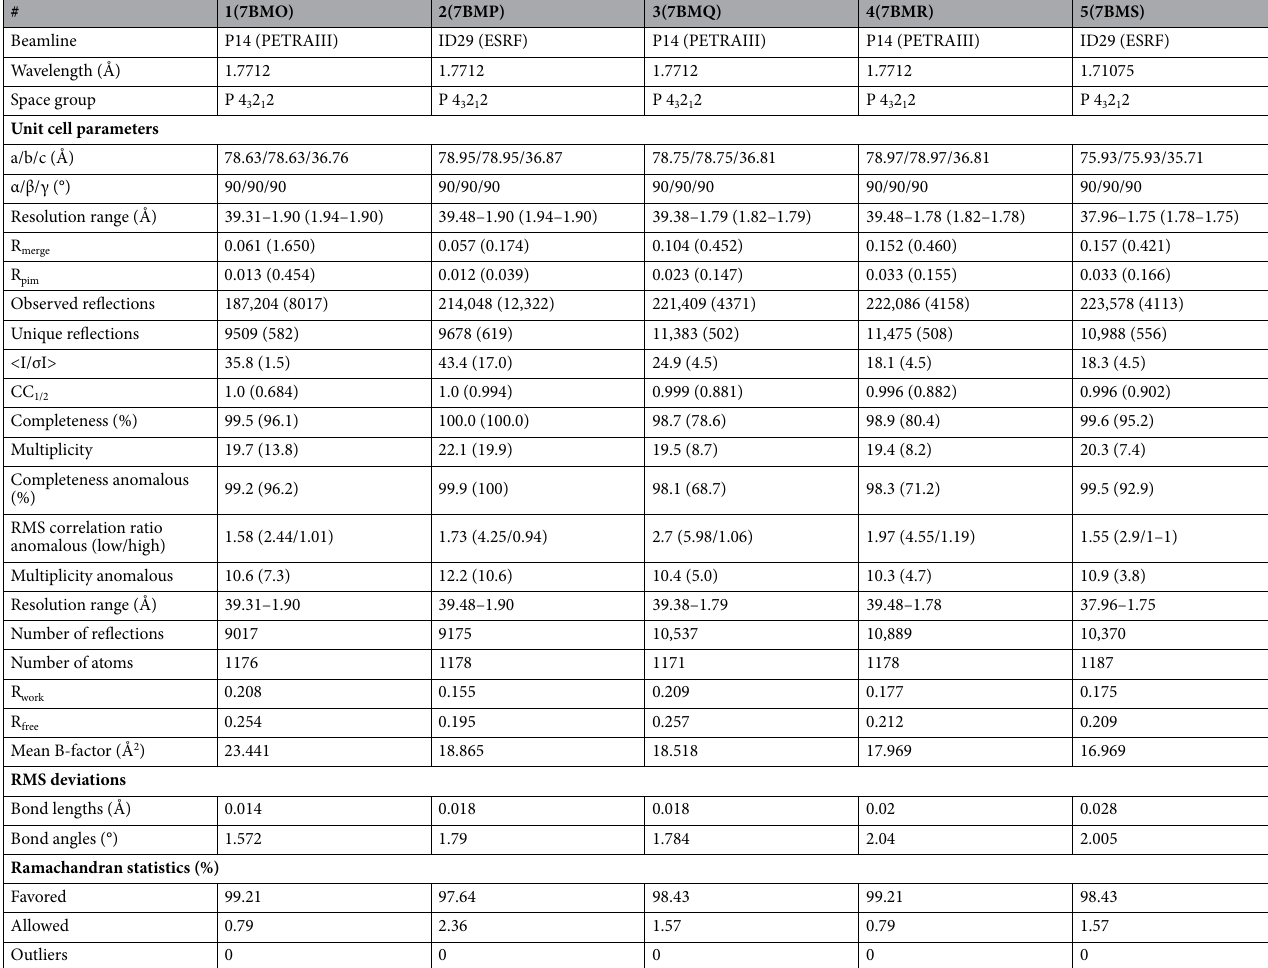
Table 2. Data collection and refinement statistics of HEWL datasets. Statistics for the highest resolution shell are given in parentheses.